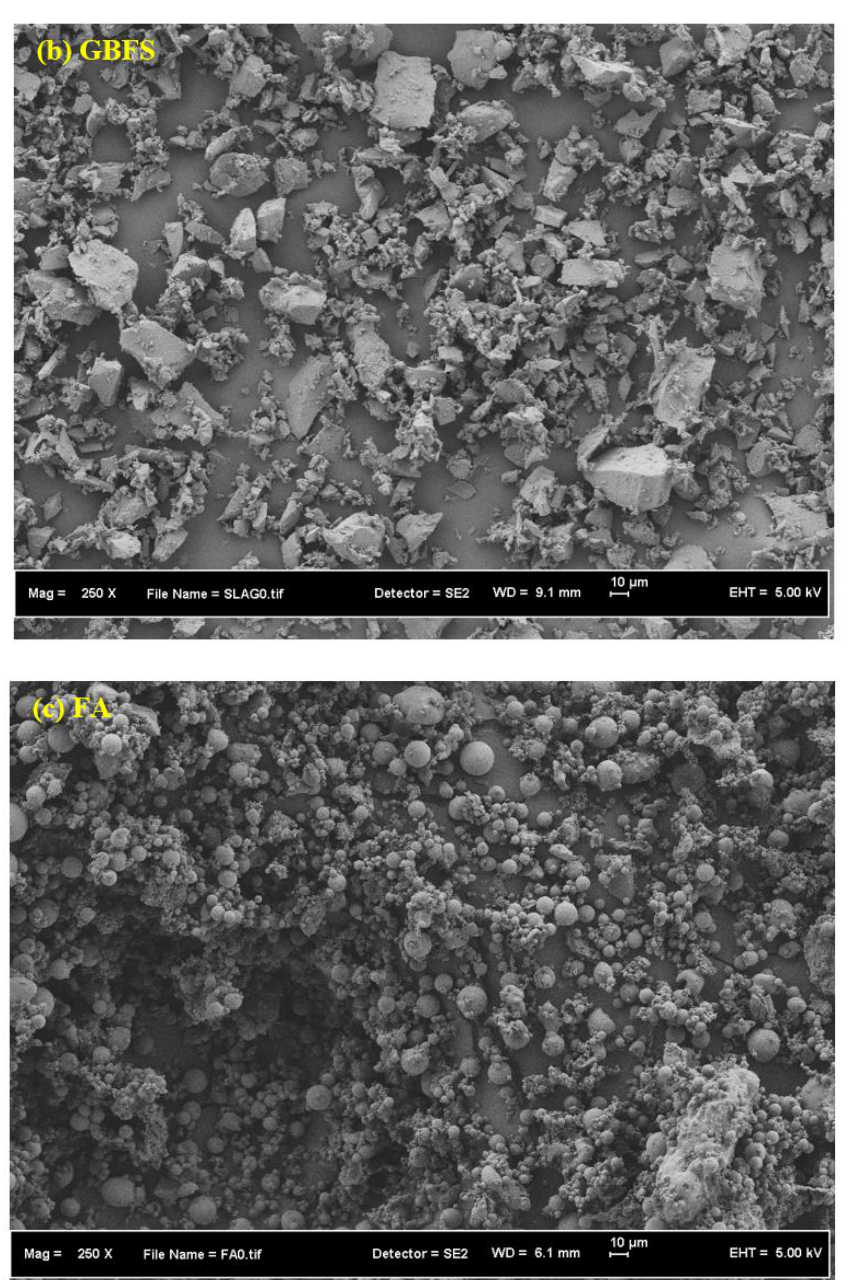
Figure 3. Scanning electronic microscopy (SEM) images of ( a ) TCWs, ( b ) GBFS and ( c ) FA. Purified sodium hydroxide (NH) pellets and a sodium silicate solution (NS) with the chemical formula SiO 2 (29.5 wt. percent), Na 2 O (14.70 wt. percent), and H 2 O were utilised in this study (55.80 wt. percent). Using the pellets, we were able to create a 4 M NH solution by dissolving them in water (Figure 4). After being refrigerated for 24 h, this was mixed with NS solution to create a 1.02 SiO 2 :Na 2 O alkaline solution (S). All alkaline solutions kept the NS:NH ratio below 0.75 to reduce the detrimental environmental effect of sodium silicate (Na 2 SiO 3 ). Sand from local rivers was used for the sieve analysis, as per ASTM C33-16. All the substance passed a 2.36 mm sieve with a specific gravity of 2.6 at a bulk density of 1614 kg/m 3 . In this case, a fineness modulus of 2.8 was used.